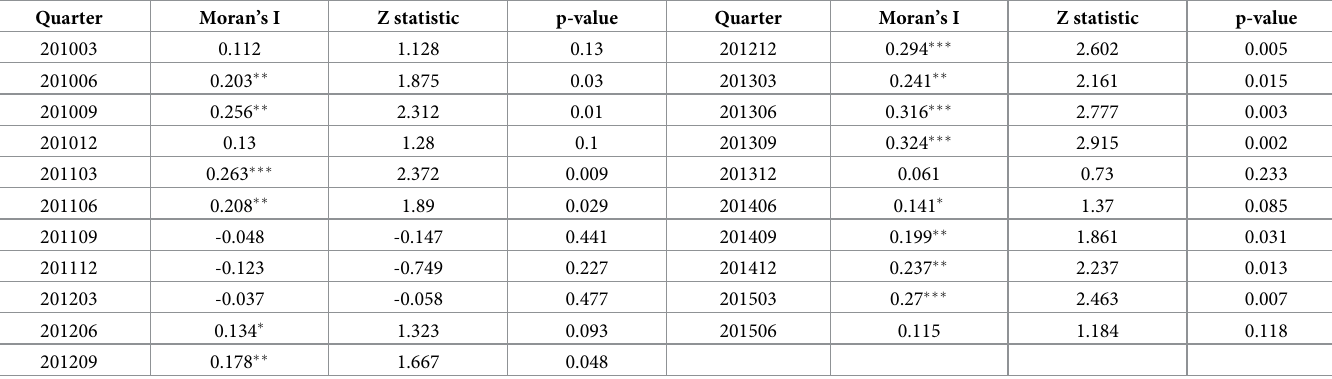
Table 3. Moran’s I of tourist satisfaction from 2010 to 2015 quarterly.